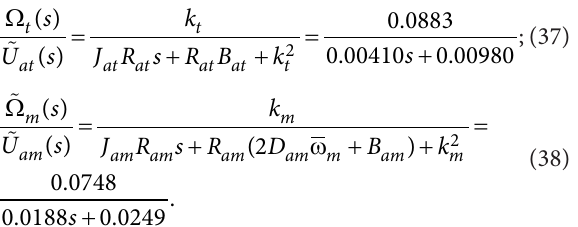
Figure 5. Input signals for DC-motors